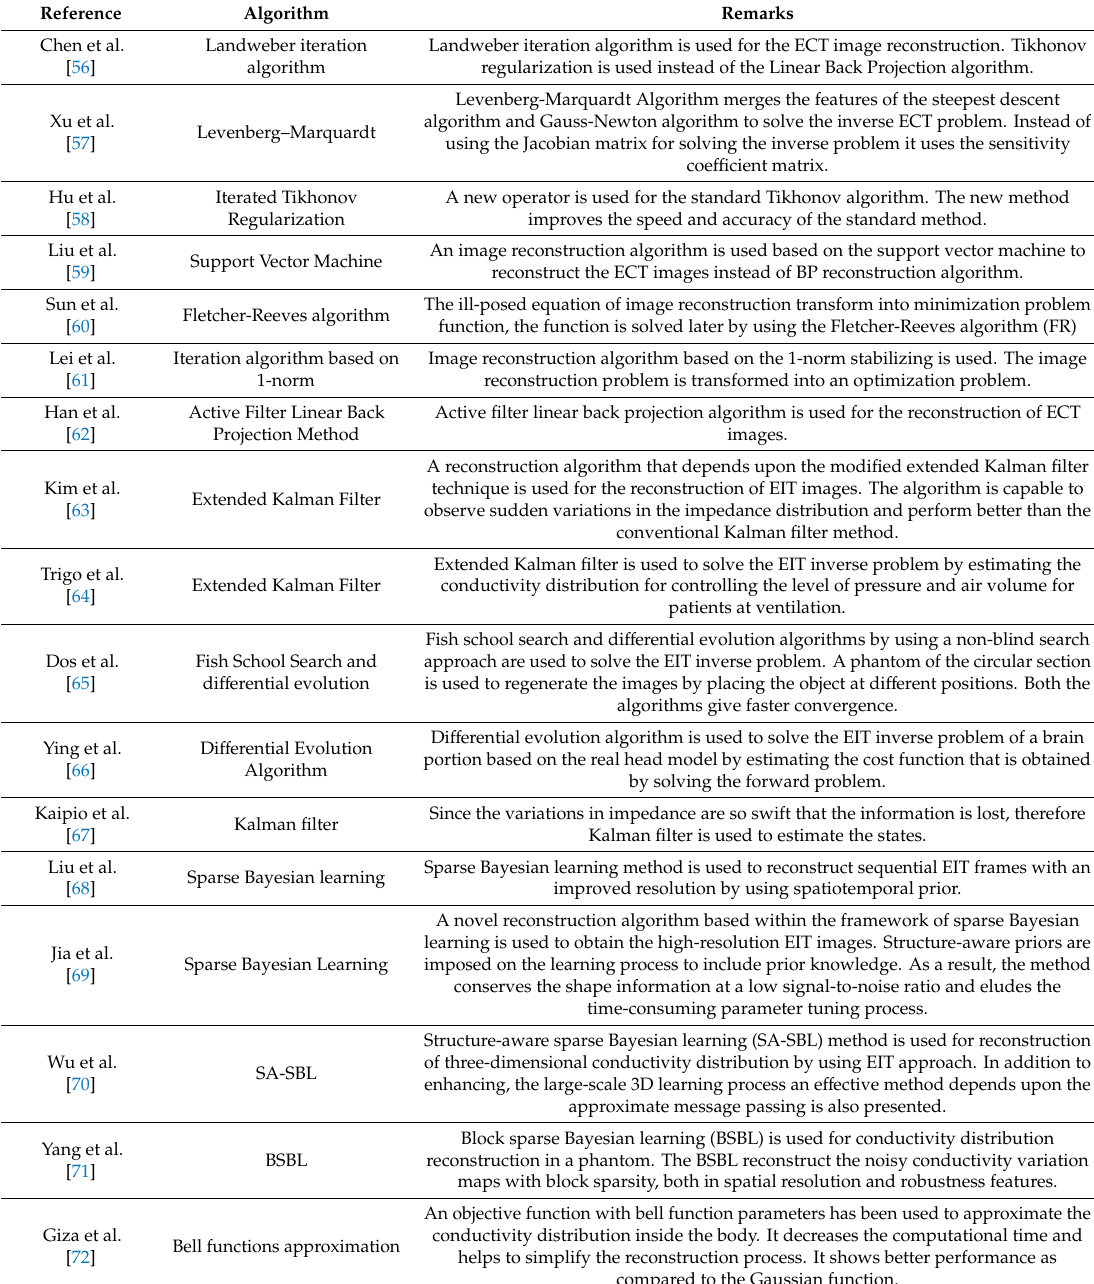
Table 4. Overview of papers using various other algorithms for solving Inverse